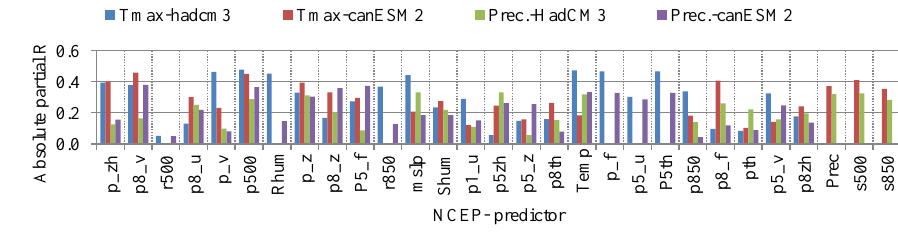
Figure 5. Average partial correlation coefficient values of all stations for precipitation and T max with NCEP